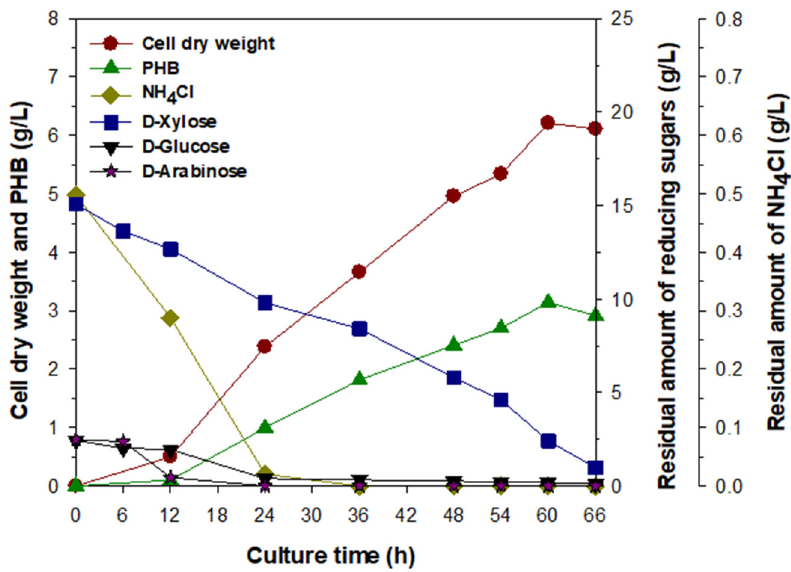
Figure 5. Fermentation kinetics of PHB production by Priestia sp. strain JY310 cultured with 20 g/L reducing sugar RHH .